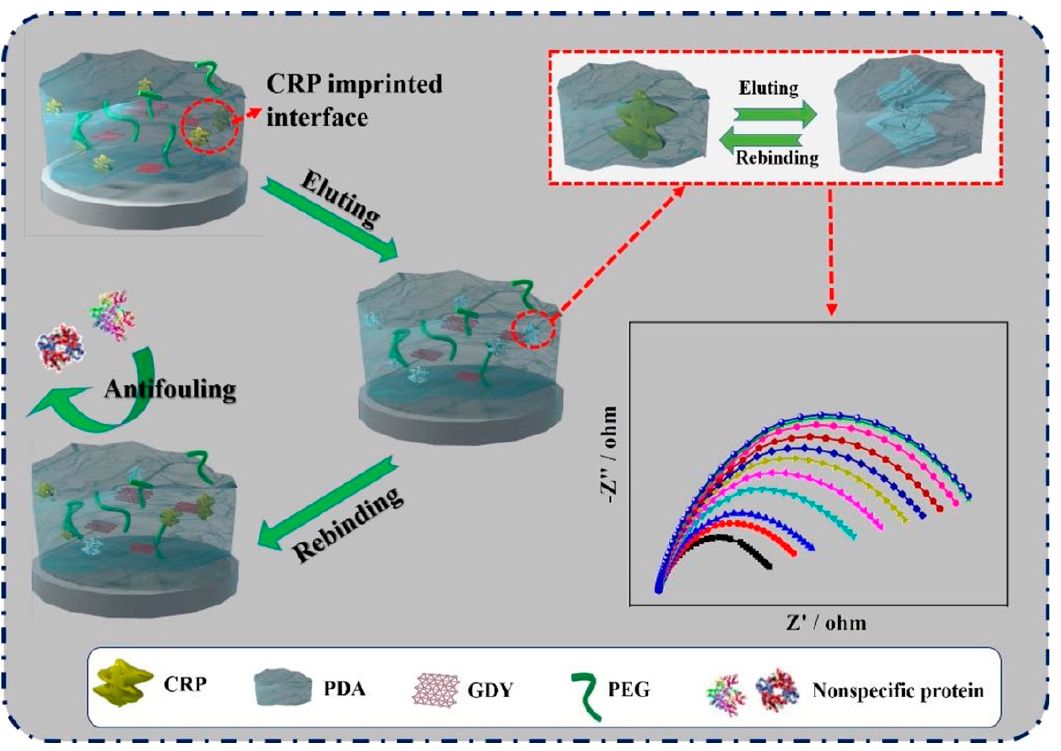
Figure 10. Schematic diagram of the CRP imprinted sensor. Reprinted from [89] with permission from Cui et al.